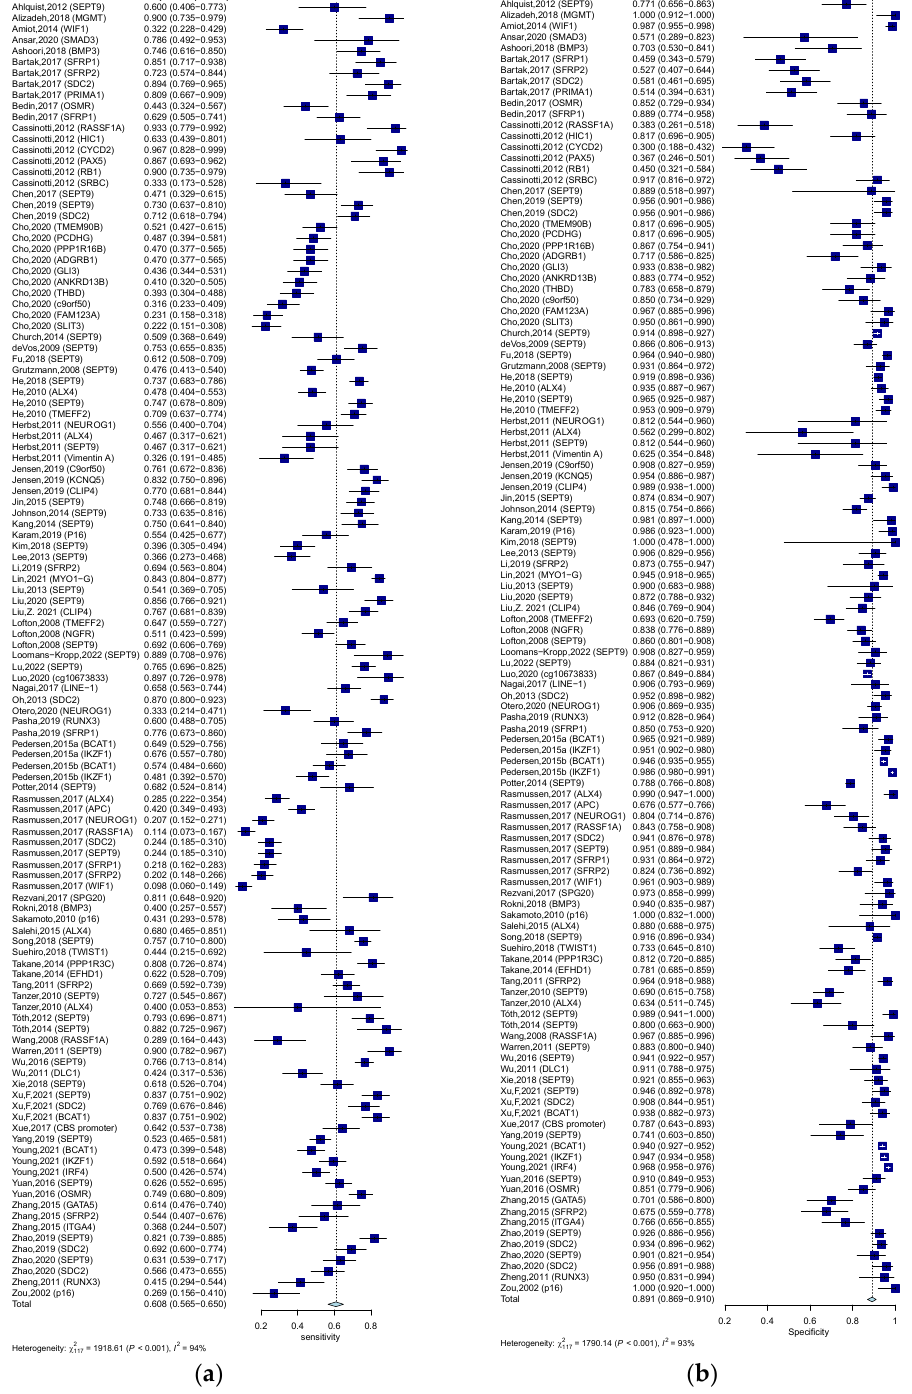
Figure 5. Forest plots of SEN ( a ) and SPE ( b ) for diagnostic value of ctDNA assay for CRC in the qualitative detection subgroup. 95% CI, 95% confidence interval; CRC, colorectal cancer; ctDNA, circulating tumor DNA; SEN, sensitivity; SPE, specificity; diamond shapes representing average effect; darkblue squares representing individual study results.